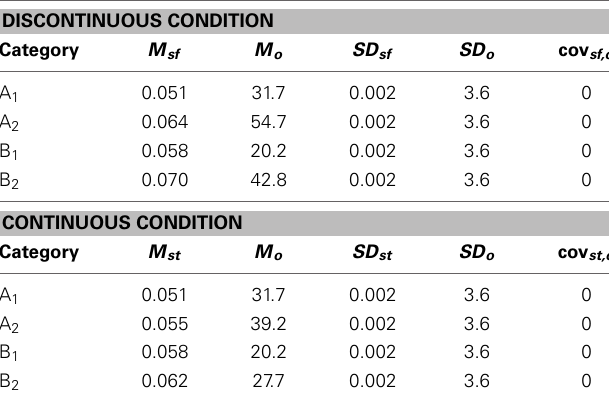
Table 4 | Category distribution parameter values for Experiment